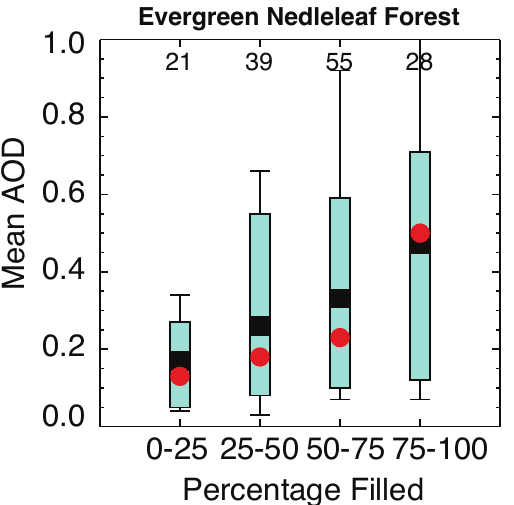
Figure 4. Distribution of mean AOD 558 with respect to percentage of the DAR filled with successful retrievals (PcntHtsFilled) over evergreen needle-leaf forest. The medians (red circles) and the means (black squares) are shown along with the central 67% (light blue box) and the central 90% (black whiskers). Similar plots for other biomes are given in Figure S1 in Supplemental Materials. The number of cases is indicated at the top of each